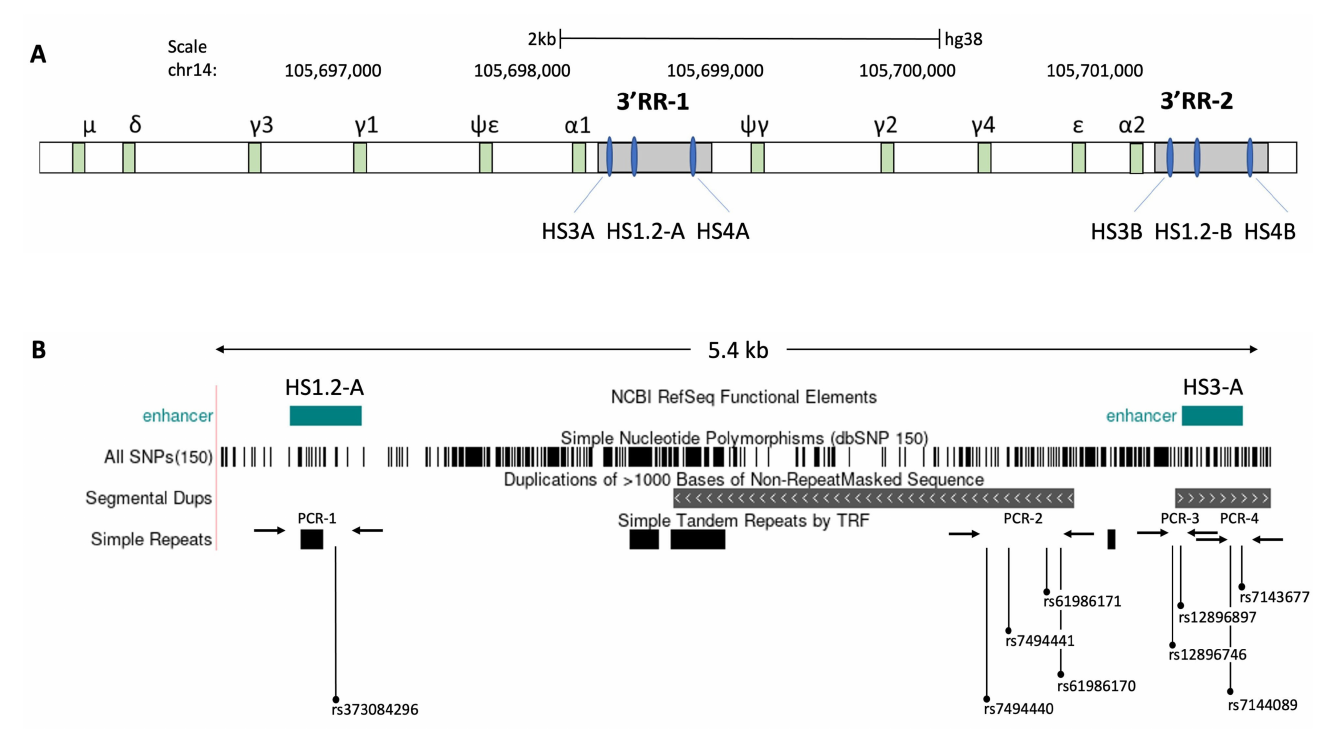
Figure 4. Schematic map and positions of the detected SNPs in the 3’ regulatory region 1 (3’RR1) of the human immuno ‐ globulin heavy chain (IgH) locus. ( A ) The Ig heavy ‐ chain region on human chromosome 14 is characterized by two dupli ‐ cated regulatory regions (3 ′ RR), located at 3 ′ of immunoglobulin (Ig) heavy chain genes . Each 3 ′ RR locus contain 3 en ‐ hancers (HS3, HS1.2 and HS3). ( B ) Schematic map of 5.4 kb region amplified by the long PCR (see method) for the detection of considered SNPs, which also includes the HS3A and HS1.2 ‐ A enhancers and regions with simple tandem repeats. After the amplification of long PCR, four different nested PCRs, highlighted by the arrows, were subsequently performed in order to identify 9 SNPs (rs373084296, rs7494440, rs7494441, rs61986170, rs61986171, rs12896746, rs12896897, rs7144089 and rs7143677) by Sanger DNA sequencing.